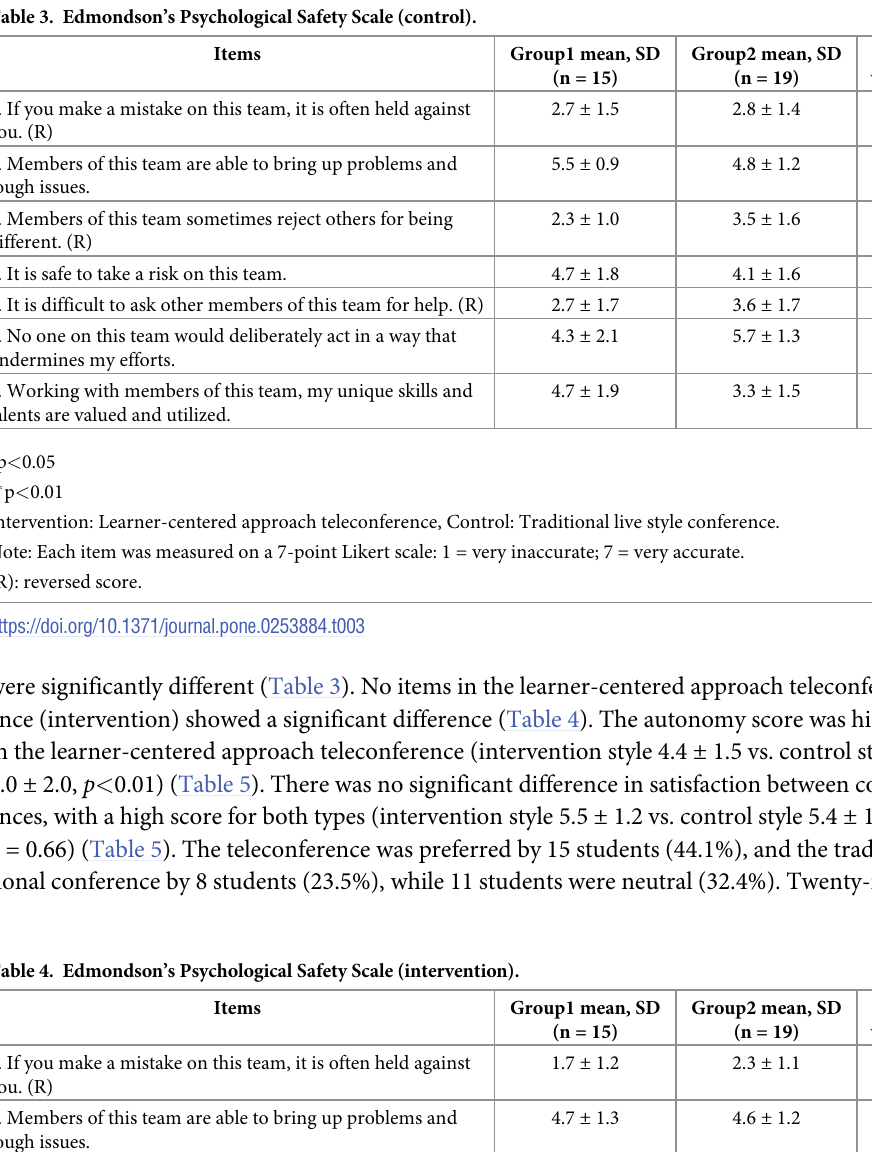
Table 3. Edmondson’s Psychological Safety Scale (control).